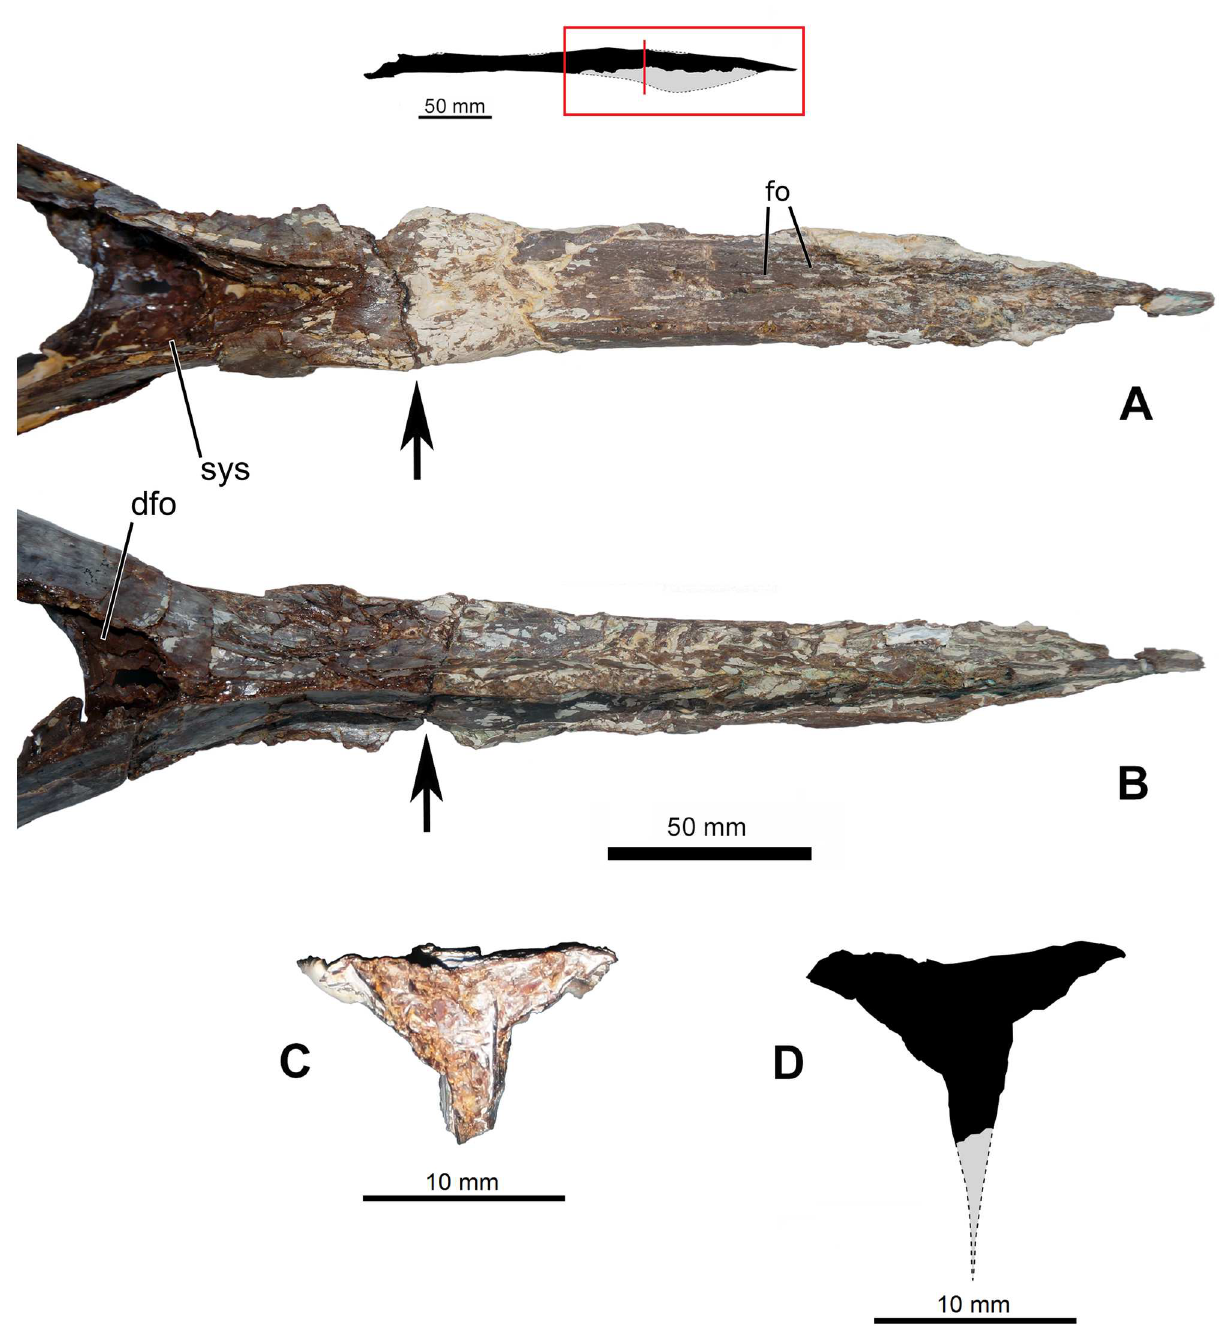
Fig 4. Mandibular symphysis of Aymberedactyluscearensis gen.et sp. nov. (MN 7596-V). (A) Reconstruction of the mandibleof Aymberedactylus cearensis , with a red box indicatingthe zoomed areasand a red line indicating the depictedcross-section. (B) Mandibular symphysis in dorsal view. (C) Mandibular symphysis in ventral view. Arrows indicatea fracturethat reveals the cross-section. (D) Cross- section.(E) Reconstructed cross section.Abbreviations: dfo = dentaryfossa, fo = foramen, sys = symphyseal shelf.